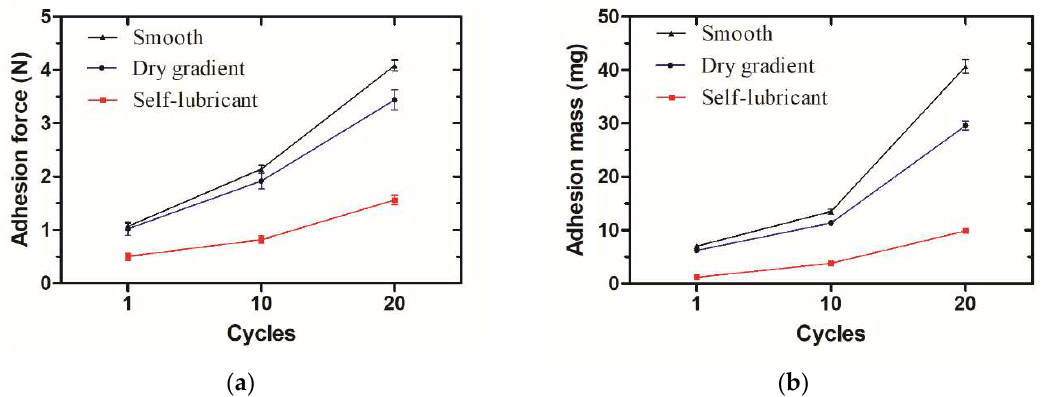
Figure 9. Contrast of anti-sticking stability between two kinds of surfaces: ( a ) Graph of adhesion force variance on the smooth, dry gradient and self-lubricating surface in cycle tests; ( b ) graph of adhesion mass accumulation of the smooth, dry gradient and self-lubricating surface in cycle tests.